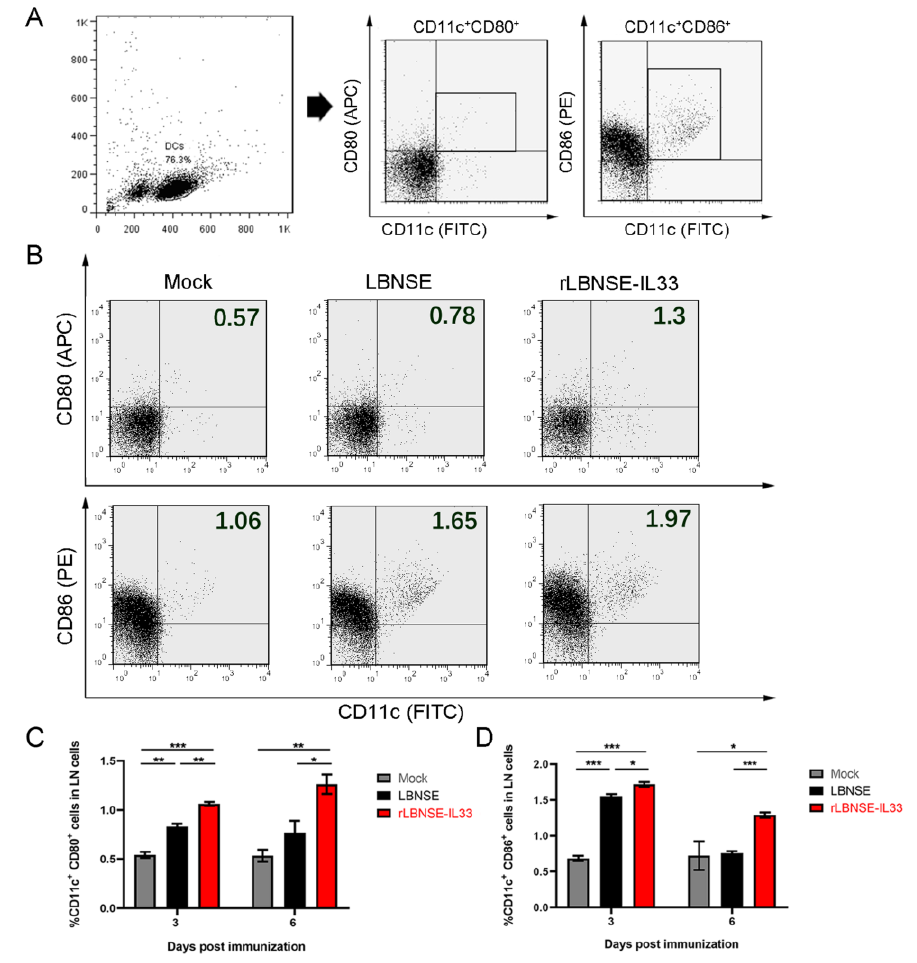
Figure 3. Overexpression of IL-33 in rRABV promotes the activation of DCs: ( A , B ) cell populations and gating strategies of DCs based on flow cytometry analysis. The inguinal LNs from mice i.m. immunized with LBNSE (10 6 FFU), rLBNSE-IL33 (10 6 FFU), or DMEM (as mock) were collected and made into 10 5 single-cell suspensions at 3 and 6 dpi, and were labeled by antibodies for analyzing DCs (CD11c + CD86 + , CD11c + CD80 + ); ( C , D ) percentage of activated DCs per 10 5 draining LN cells in three immunized groups at 3 dpi ( C ) and 6 dpi ( D ). The standard errors (SE, n = 3) was illustrated by error bars, and the data were analyzed by unpaired two-tailed t -test. Significant differences between groups were indicated at three levels: *, p < 0.05; **, p < 0.01; and ***, p < 0.001.